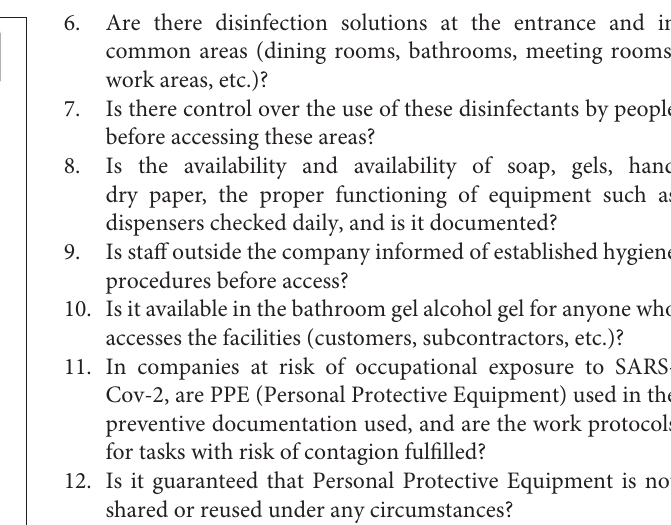
Figure 2 lists the audit control